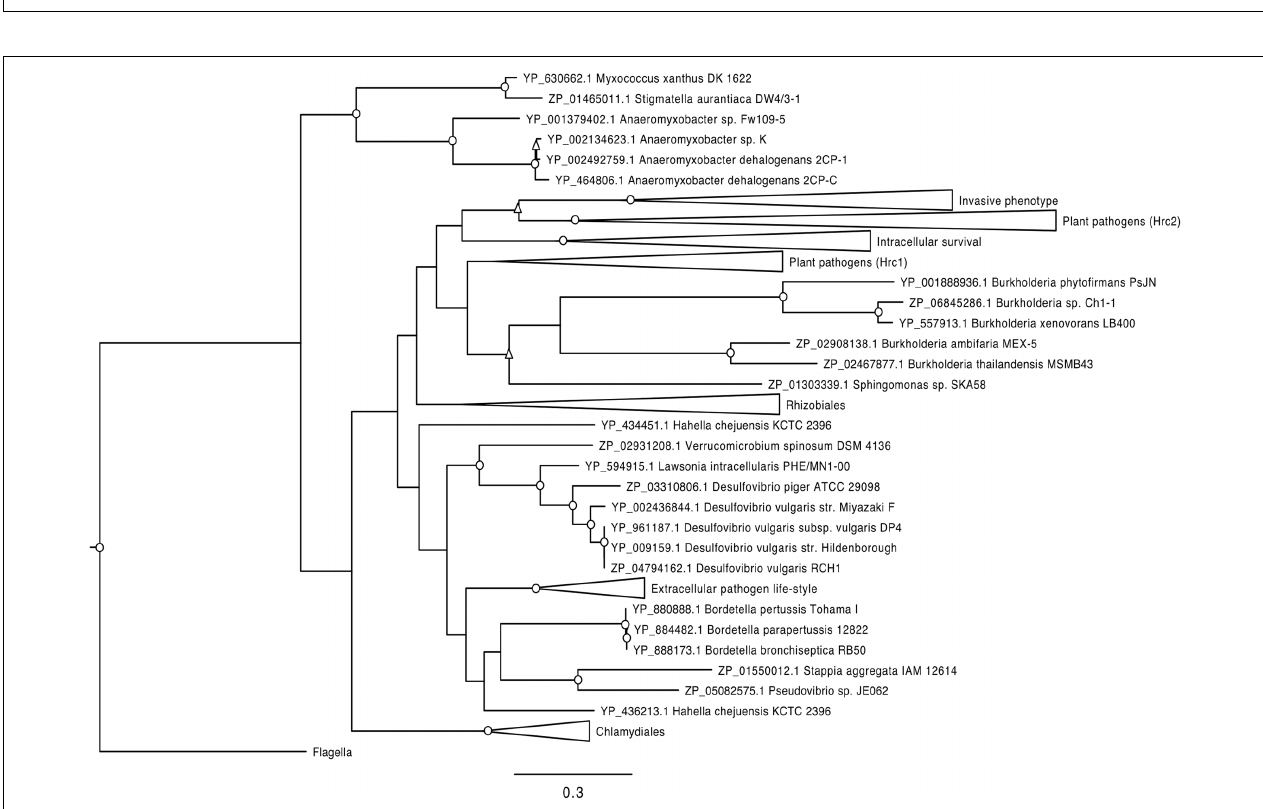
FIGURE 5 | Caenorhabditis elegans survival assays. Each experiment comprised of approximately 100 worms. (A) CF512 worms (sterile mutants) exposed to E. faecalis and V. spinosum died faster than CF512 worms exposed to E. coli , according to log-rank analysis ( p = 0 for E. faecalis and